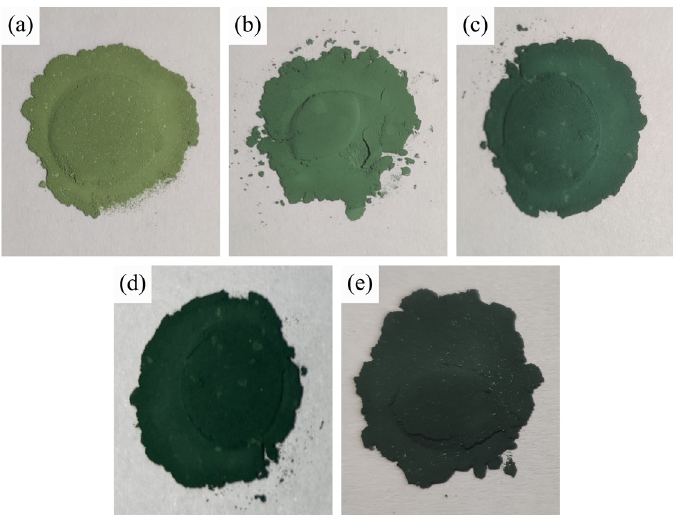
Figure 9. Photographs of the composite pigment powders obtained after calcination at 800 °C for samples with different Co/Ni molar ratios: ( a ) 0.1:0.9, ( b ) 0.3:0.7, ( c ) 0.5:0.5, ( d ) 0.7:0.3, ( e ) 0.9:0.1.